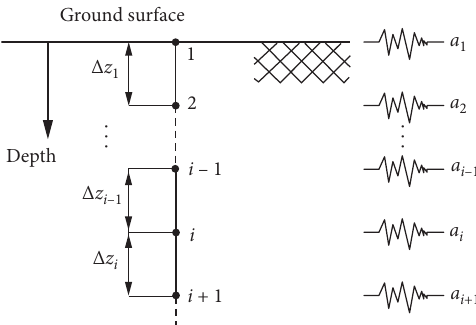
Figure 6: Sketch for computing shear stress in the model